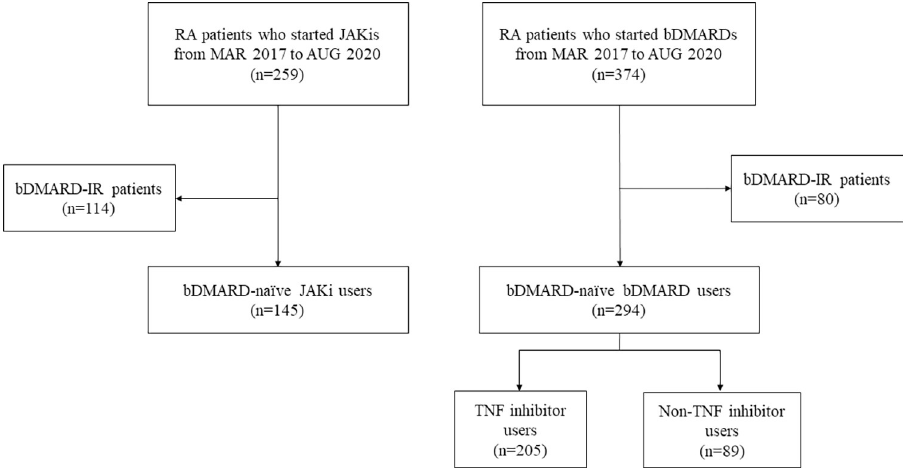
Fig 1. Flow of patient selection. RA, rheumatoid arthritis; JAKi, Janus kinase inhibitor; bDMARD, biological disease- modifying antirheumatic drugs; IR, inadequate response; TNF, tumor necrosis factor.